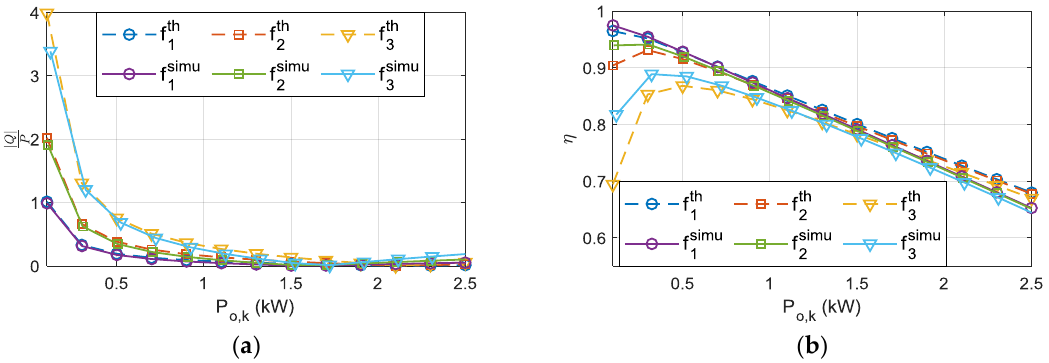
Figure 7. Reactive power supplied by multi-channel inverter to LCL components over the various channels: ( a ) Reactive power supply using Equation (8) and simulation study; ( b ) power exchange efficiency over various channels.